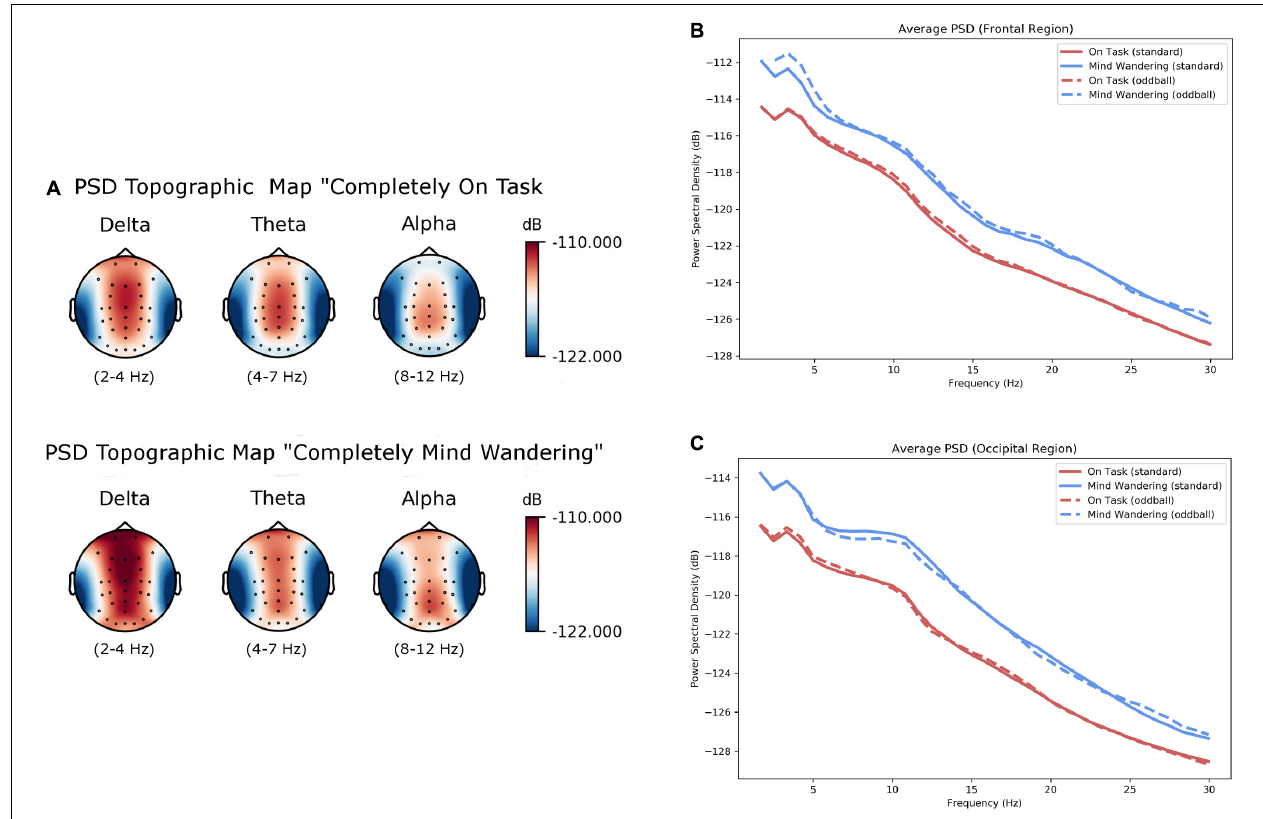
FIGURE 3 | Effect of the extremes of the mind wandering states (“completely on task,” “completely mind wandering”) on power spectral density (PSD). (A) Topographic illustrations of PSD for the two states illustrate differences in delta and theta power in the frontal region, as well as increased alpha in the occipital region. (B) Average PSD in response to various stimuli are illustrated for channels Fz, Fp1, Fp2, F3, and F4 are represented. (C) Average PSD in response to various stimuli are again represented but for channels Poz, Oz, O1, and